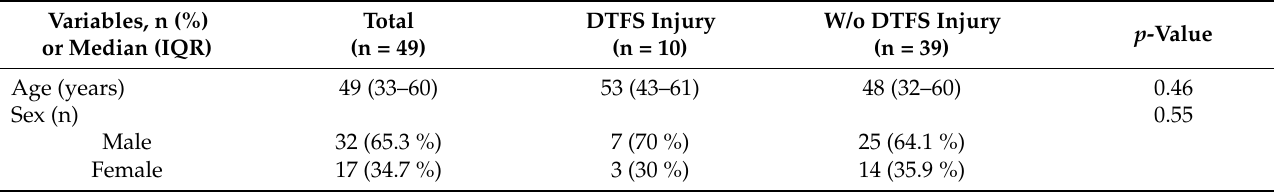
Table 1. Characterization of the patient population.